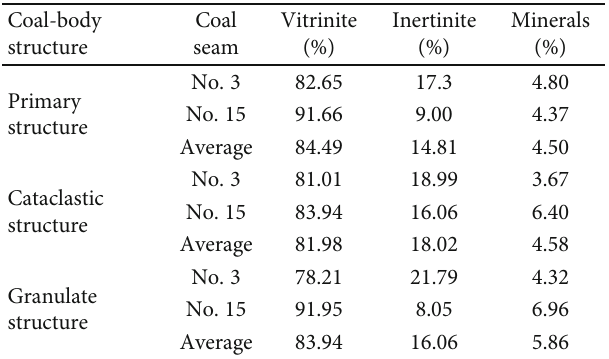
Table 4: Statistics of macerals of coal with di ff erent coal-body structures in the Mabidong block.